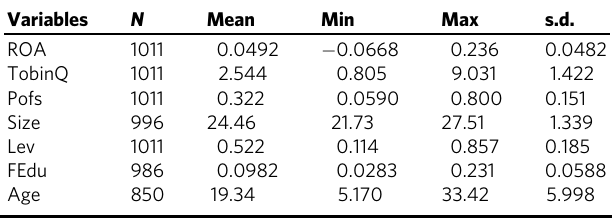
Table 3 Descriptive statistics of variables.